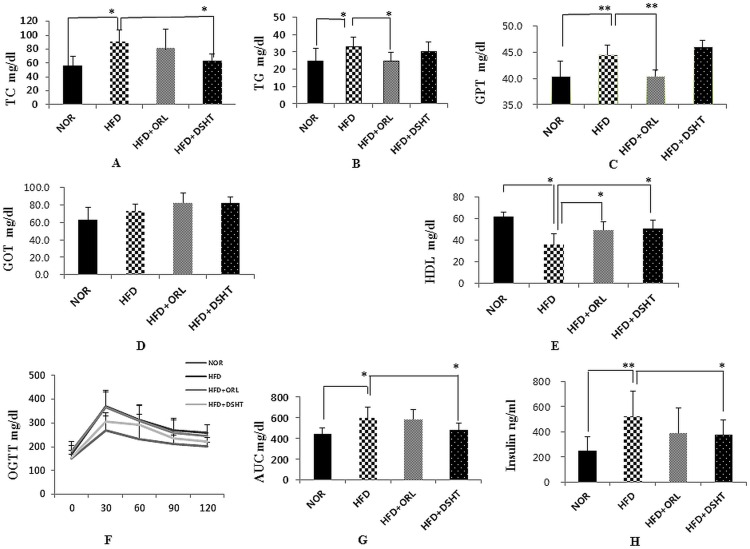
Effect of DSHT on biochemical parameter, glucose homeostasis, and insulin resistance in HFD-fed C57BL/6 mice.(A) The TC levels of normal (NOR), high fat diet (HFD), orilistat (ORL), and daesiho-tang (DSHT) treated animals after 12 weeks. (B) The TG levels of NOR, HFD, HFD+ORL and HFD+DSHT treated animals. (C) The GPT levels of NOR, HFD, HFD+ORL and HFD+DSHT treated animals. (D) The GOT levels of NOR, HFD, HFD+ORL and HFD+DSHT treated animals. (E) The HDL levels of NOR, HFD, HFD+ORL and HFD+DSHT treated animals. (F) Oral Glucose Tolerance test (OGTT) of normal (NOR), high fat diet (HFD), orilistat (ORL) and daesiho-tang (DSHT) fed animals after 12 weeks. (G) Area under curve of NOR, HFD, HFD+ORL and HFD+DSHT fed animals. (H) Fasting insulin of NOR, HFD, HFD+ORL and HFD+DSHT fed animals. Data were represented as mean ± SD (n = 7). The results were compared by Student’s t-test (** corresponds to p<0.005, * corresponds to p<0.05). The error bars represent the SD.